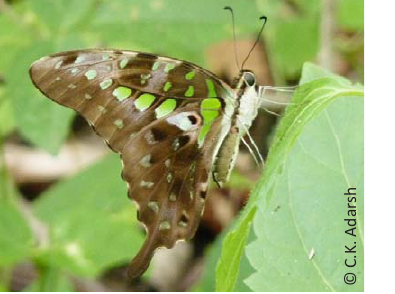
Image 6. Papilio clytia Common Mime